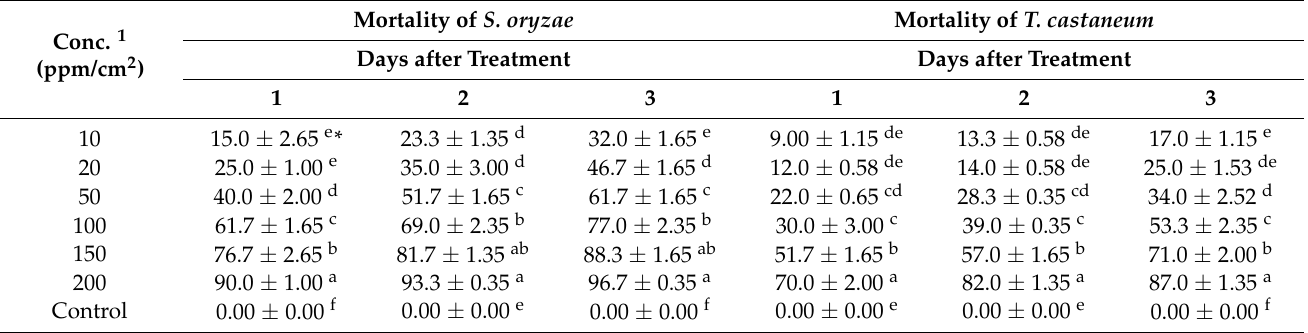
Mortality of T. castaneum